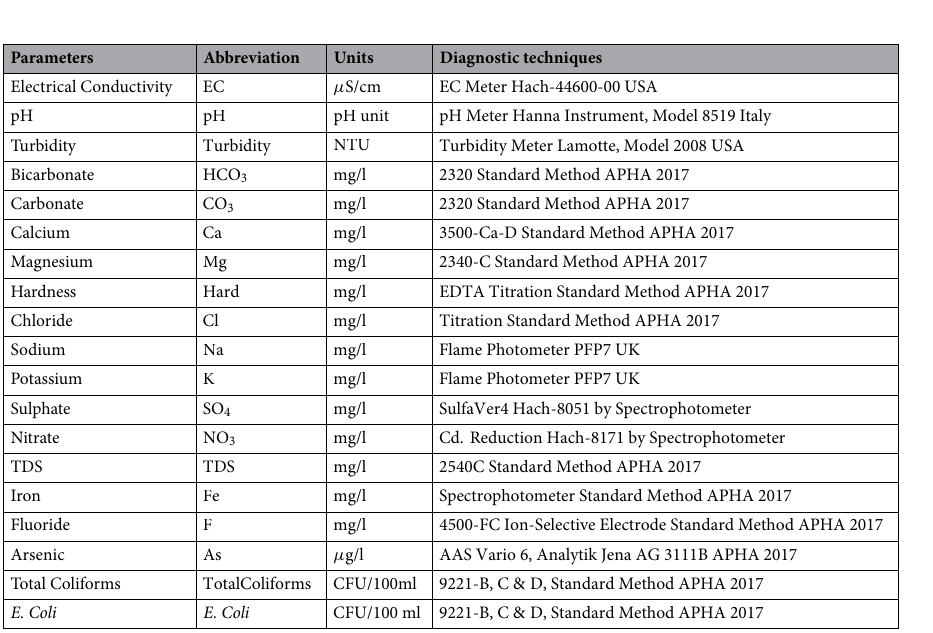
Figure 1. Coordinates placement of elected locations in lahore (https:// www. mathw orks. com/ help/ matlab/ ref/ geoba semap. html).